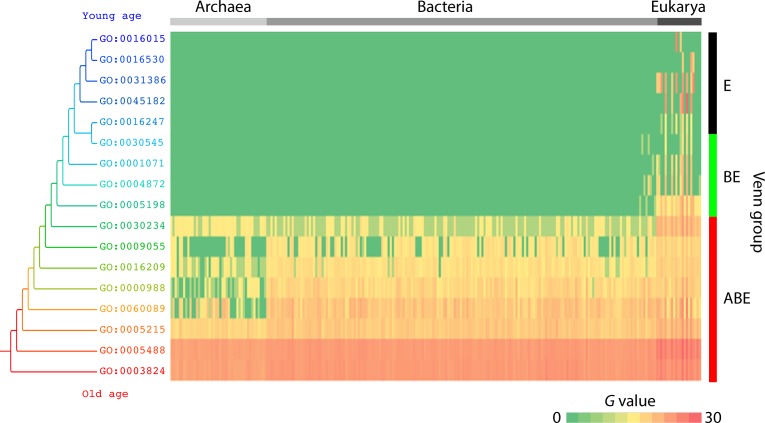
The heat map defines the distribution of genomic abundances (g) of 17 level 1 GO terms in the 249 organisms along the timeline (nd).